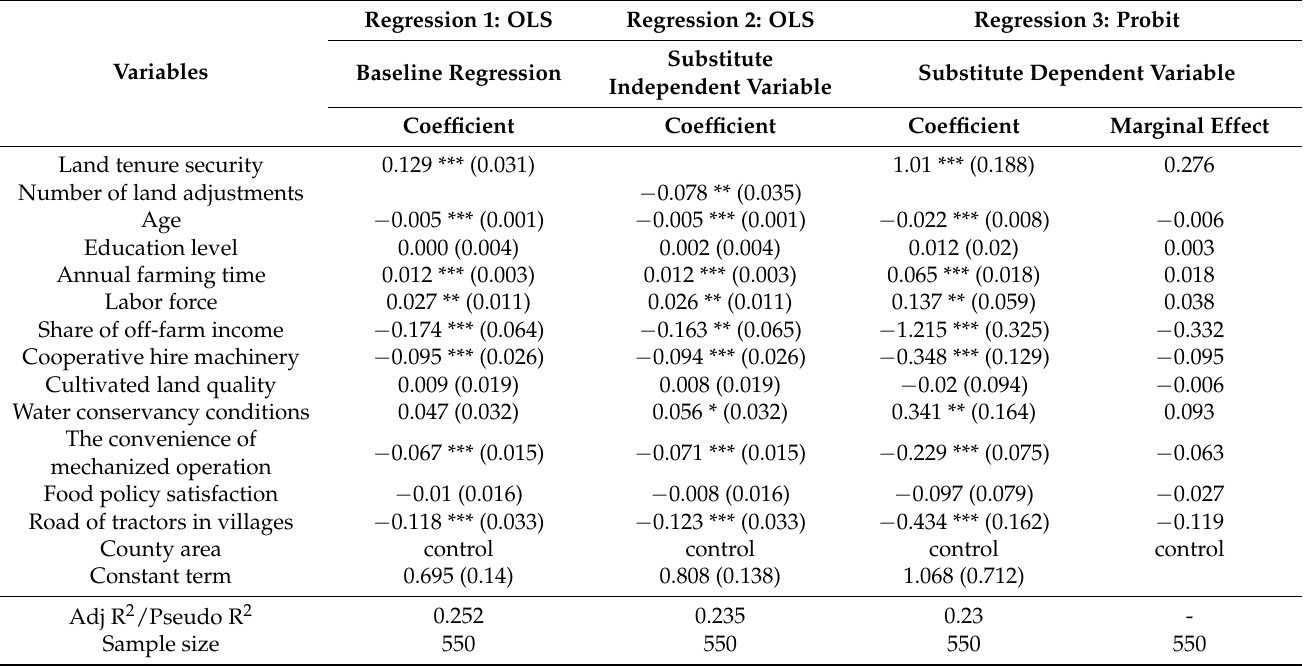
Table 2. Land tenure security and cultivated land